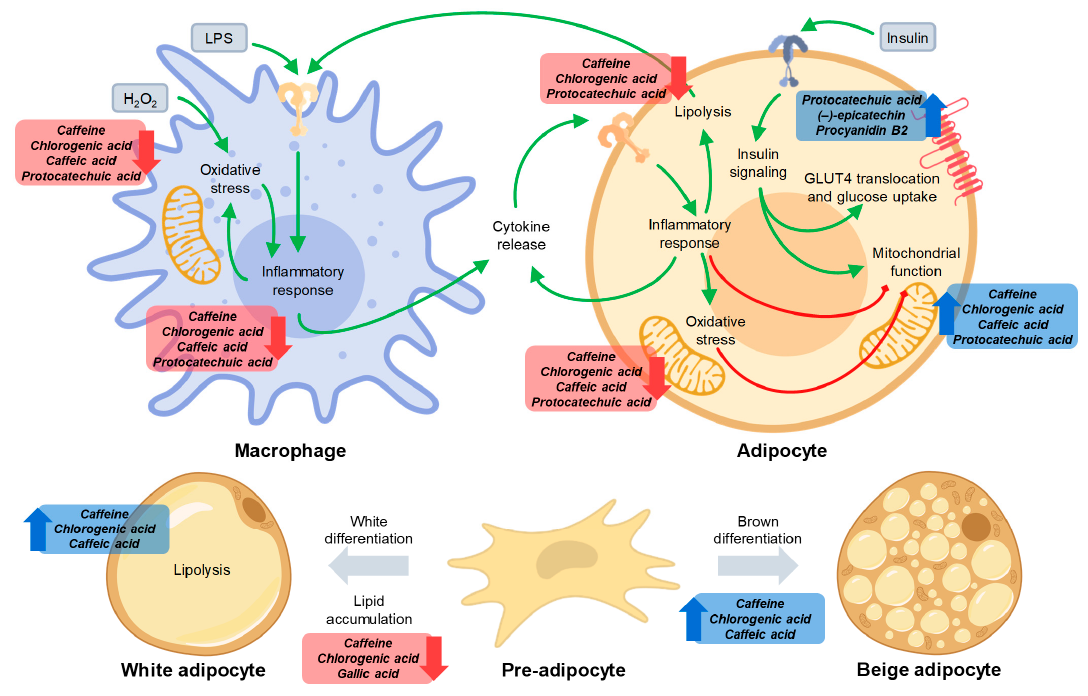
Figure 4. Integrative diagram illustrating the underlying molecular mechanism of the phytochemicals from coffee husk, coffee silverskin, and cocoa shell in inflammation, oxidative stress, adipogenesis, and insulin resistance in macrophages and adipocytes.